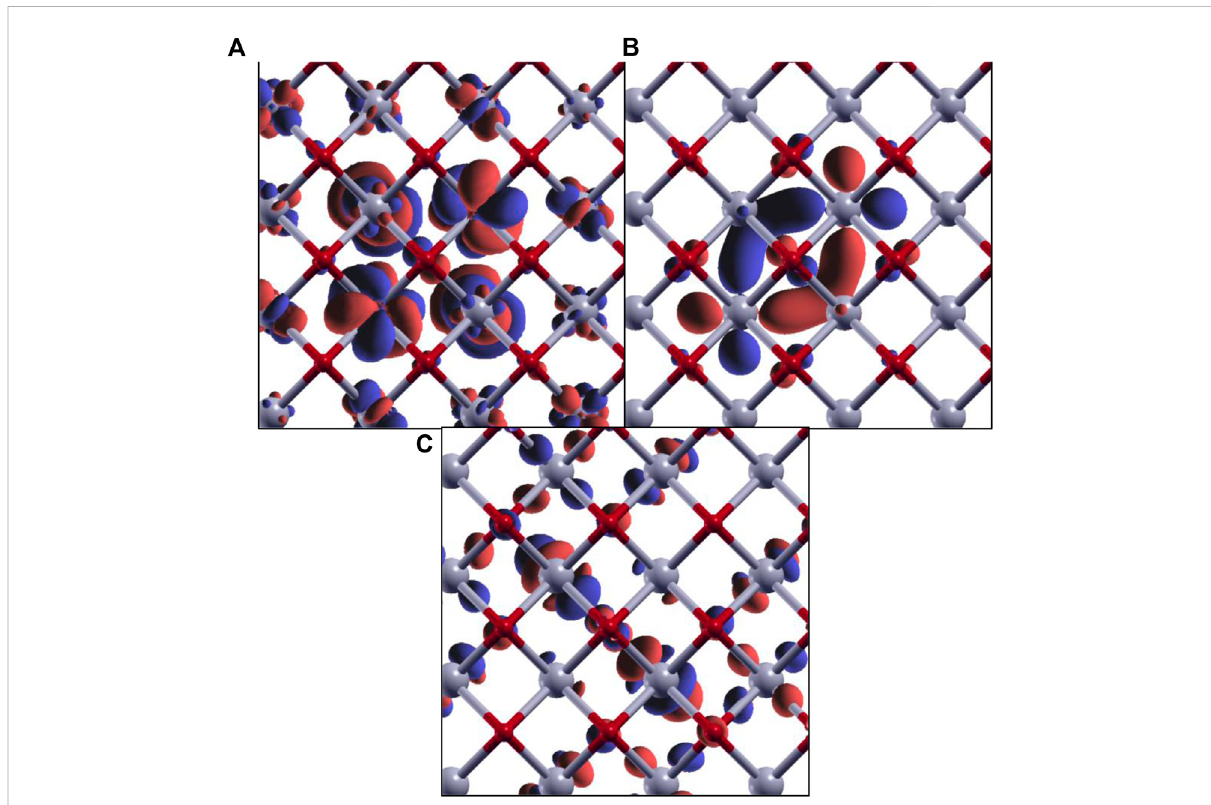
FIGURE 11 Isovalue plots ofKSorbitalsofthecore-excited state withsigni fi cantcontribution inthe fi rst (A) ,second (B) , andthird (C) peaksintheO K -edge MBXAS plot, as shown in Figure 10 (green line). The red and gray spheres represent oxygen and cerium atoms, respectively. Note that these are all hybrid orbitals containing O p and Ce d / f characters, with different degrees of